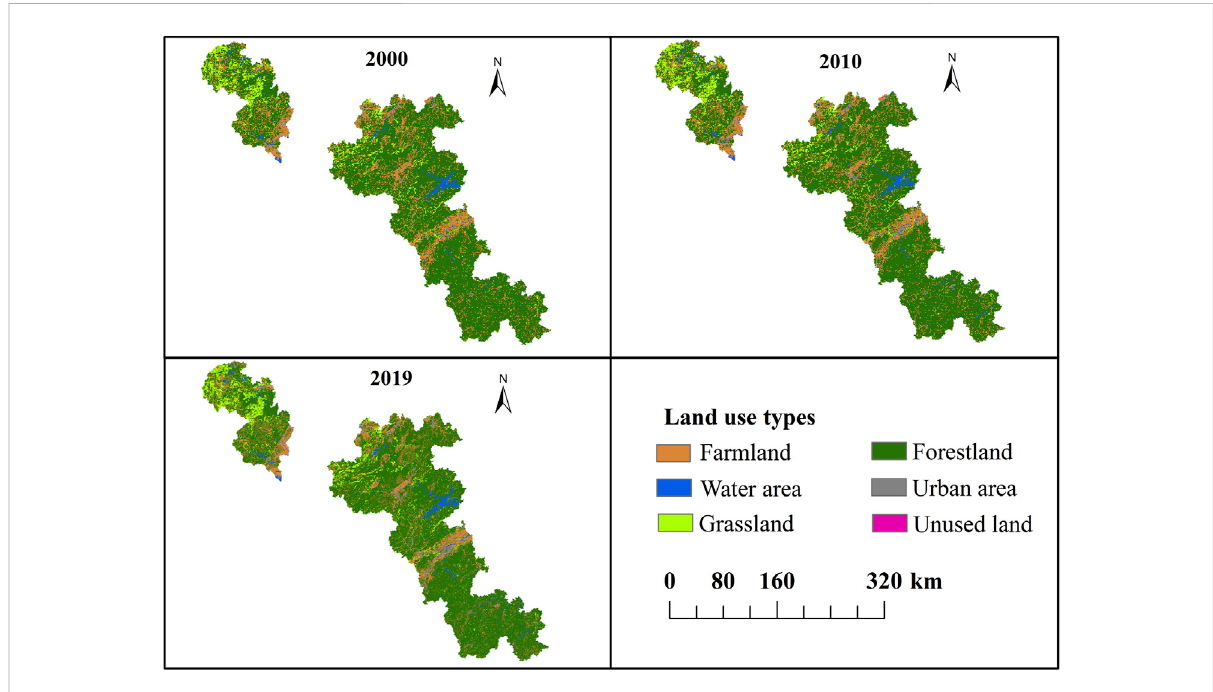
FIGURE 3 Spatial distribution of land use types in YRDEB from 2000 to